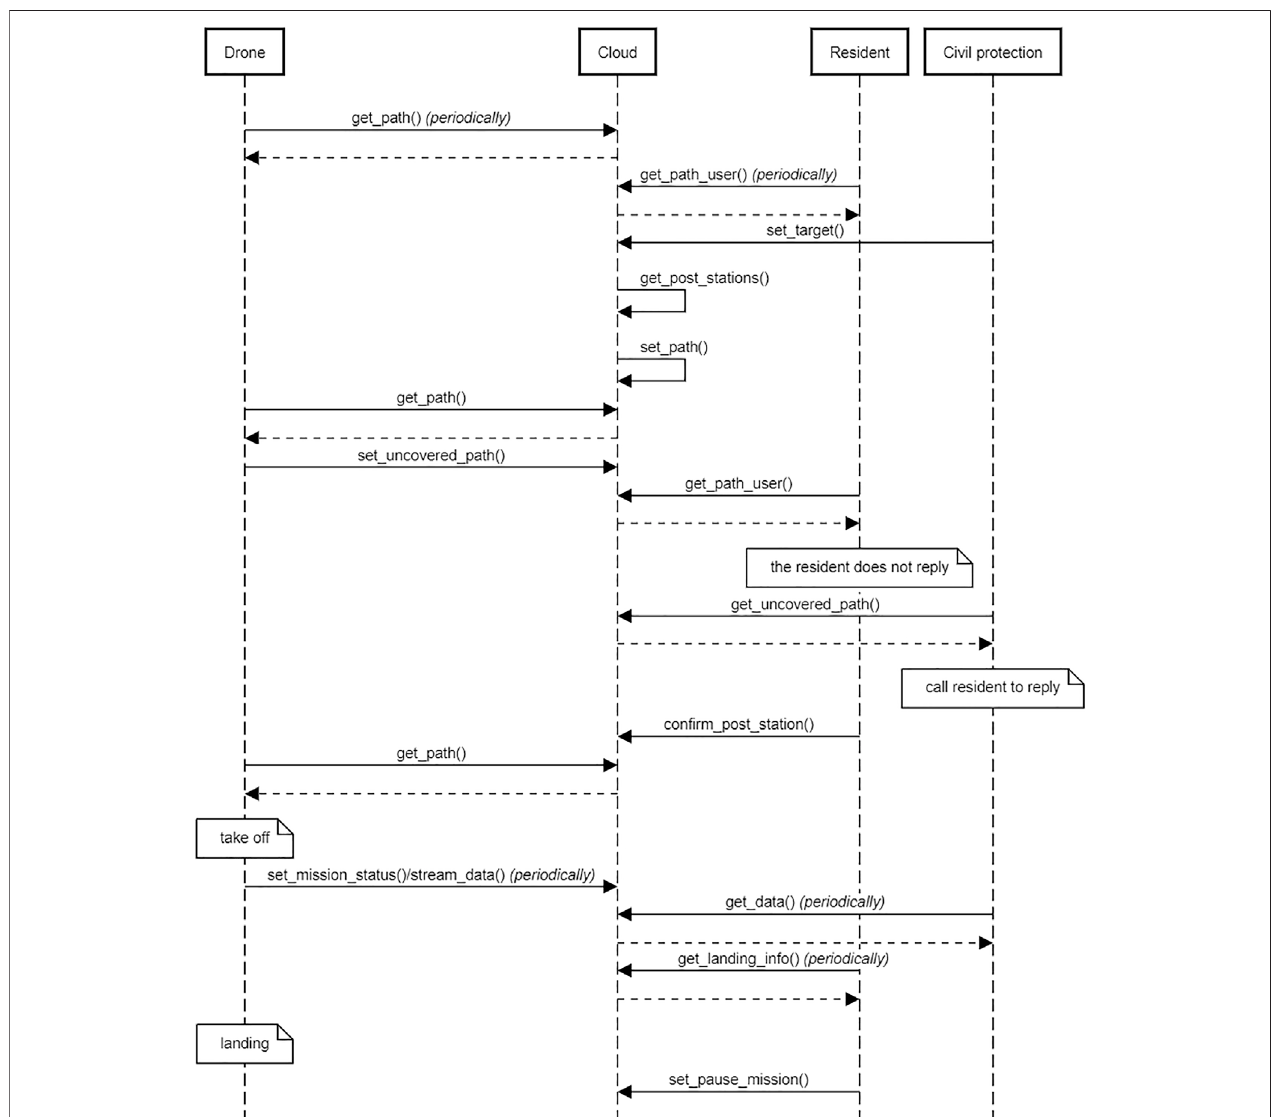
FIGURE 4 | Sequence diagram representing the chain of events involving the Civil protection, resident volunteers and drones.